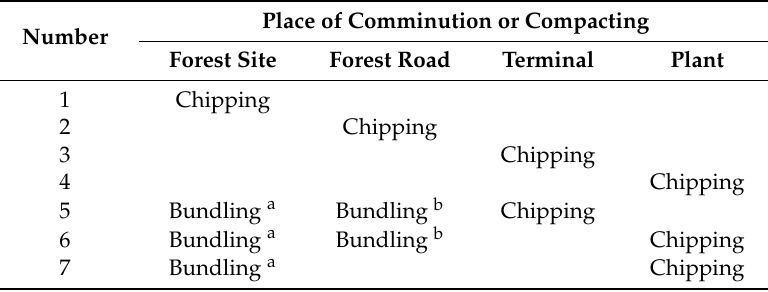
Table 1. Classification of technical systems for logging residue harvesting [52]. Place of Comminution or Compacting Number Forest Site Forest Road Terminal Plant 1 Chipping 2 Chipping 3 Chipping 4 Chipping 5 Bundling a Bundling b Chipping 6 Bundling a Bundling b Chipping 7 Bundling a